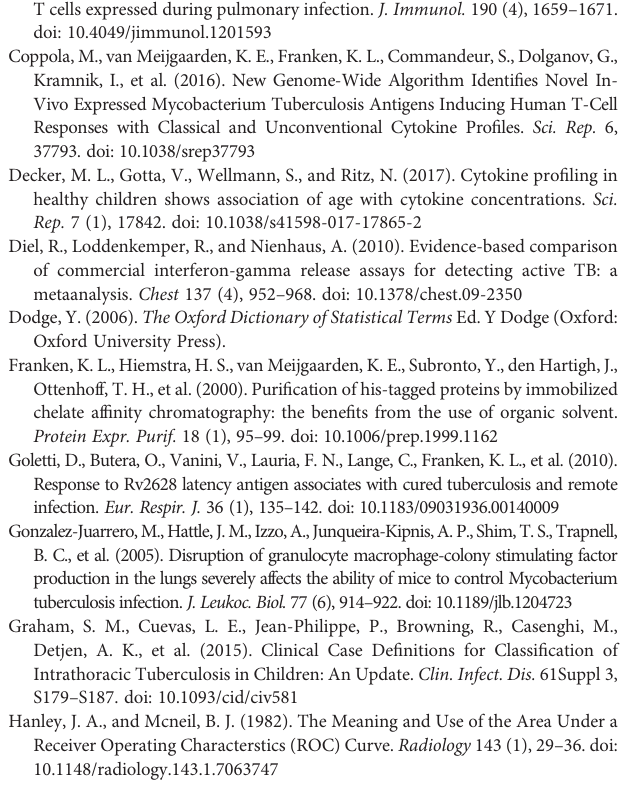
SUPPLEMENTARY FIGURE 1 | relativemediancytokineconcentrations,(color changefromdarkbluetolightgreenindicatesanincreaseinrelativecytokineconcentration). Non-normalizeddata (A) ,min – maxnormalizeddata (B) ,mean – stdnormalizeddata (C) , min – maxnormalizedandmean – stdnormalized(betweenindividuals)data (D) . SUPPLEMENTARY FIGURE 2 | Normalization of data contributes to the performance of a discriminative classi fi er. Combination of 10 antigen – cytokine pairs contributing the most to the performance of a trained discriminative classi fi er according to different normalization methods applied: (A) non-normalized data (B) min – max normalized data and (C) mean – std normalized data. SUPPLEMENTARY FIGURE 3 | Normalized cytokine concentrations for individual patients (n = 71) and selected antigen – cytokine pairs sorted by clusters (A) and study group (B) (color change from dark blue to light green indicates an increase in relative cytokine